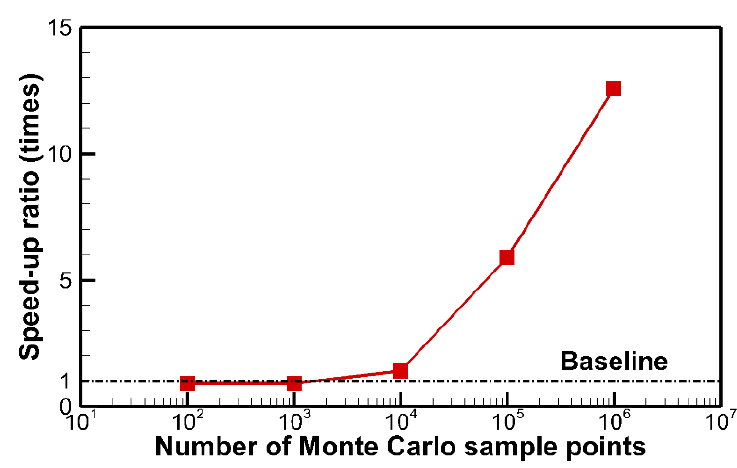
Figure 6. Speedup ratio of total cost to different numbers of Monte Carlo sample points.